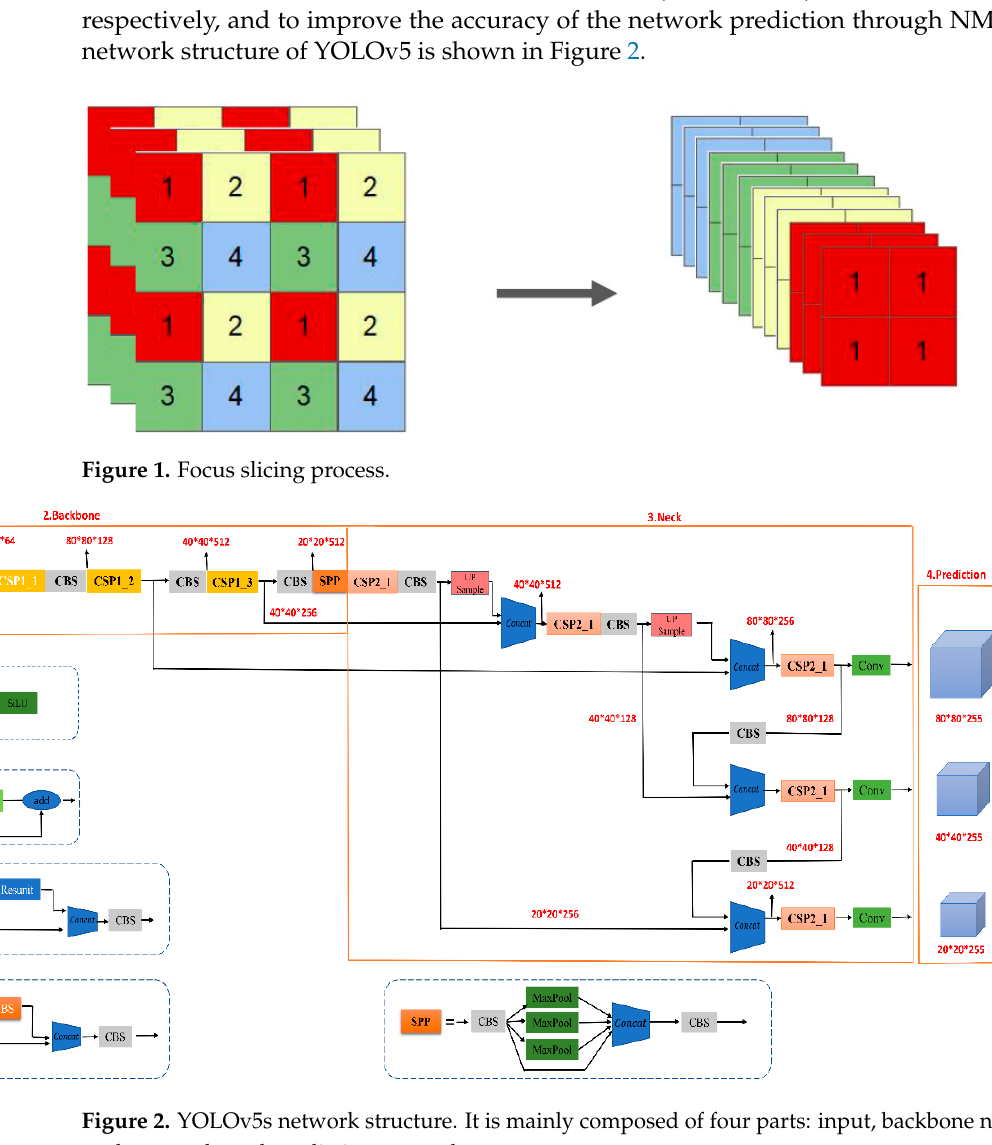
Figure 2. YOLOv5s network structure. It is mainly composed of four parts: input, backbone net- work, neck network, and prediction network. 3. Proposed Method The MR-YOLO model is optimized on the basis of YOLOv5s, and the improved struc- ture is shown in Figure 2. The overall network structure consists of three parts: backbone network, feature fusion network, and output layer. The model applies the lightweight network structure MobileNetv3, replacing its backbone network (backbone) with the im- proved MobileNetv3-YOLOv5 structure. MobileNetv3 greatly improves the module pro- cessing speed, increases the efficiency of the overall model, and reduces the model size. The CSPNet network structure is also introduced in the backbone network to eliminate the duplicate features and computational bottlenecks generated during the computation, further ensuring the accuracy and speed of the model. Finally, the output layer replaces